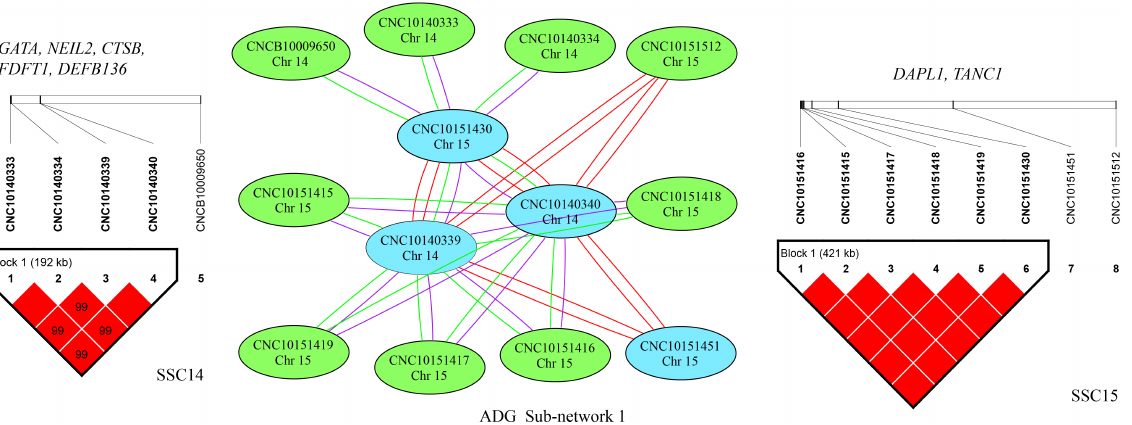
Figure 3. Epistatic sub-network 1 among SNPs affecting ADG and the related LD information. The color of a node represents the p -value of an interaction ( p < 1 × 10 − 12 = red; p < 1 × 10 − 11 = blue; p < 1 × 10 − 10 = green). The color of connecting lines between circles indicates the type of epistatic effect (A × A = red; A × D = purple; D × D = green). The genes located in the LD block are listed.